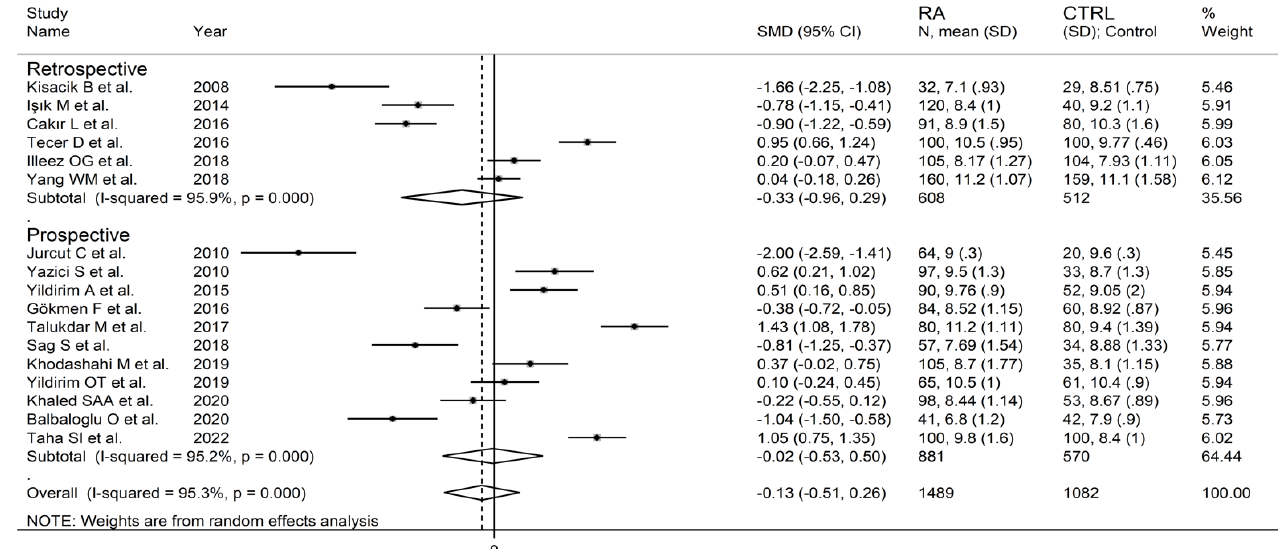
Figure 6. Forest plot of studies examining the mean platelet volume in patients with rheumatoid arthritis and healthy controls according to the country where the study was conducted.